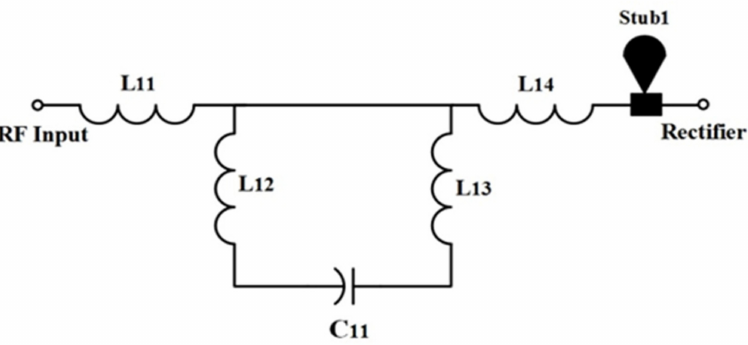
Figure 14. The single RF filter (matching network) including a microstrip matching element for maintaining loads ranging from 0.5 k Ω to 25 k Ω for the RF input power levels of − 35 to − 10 dBm.